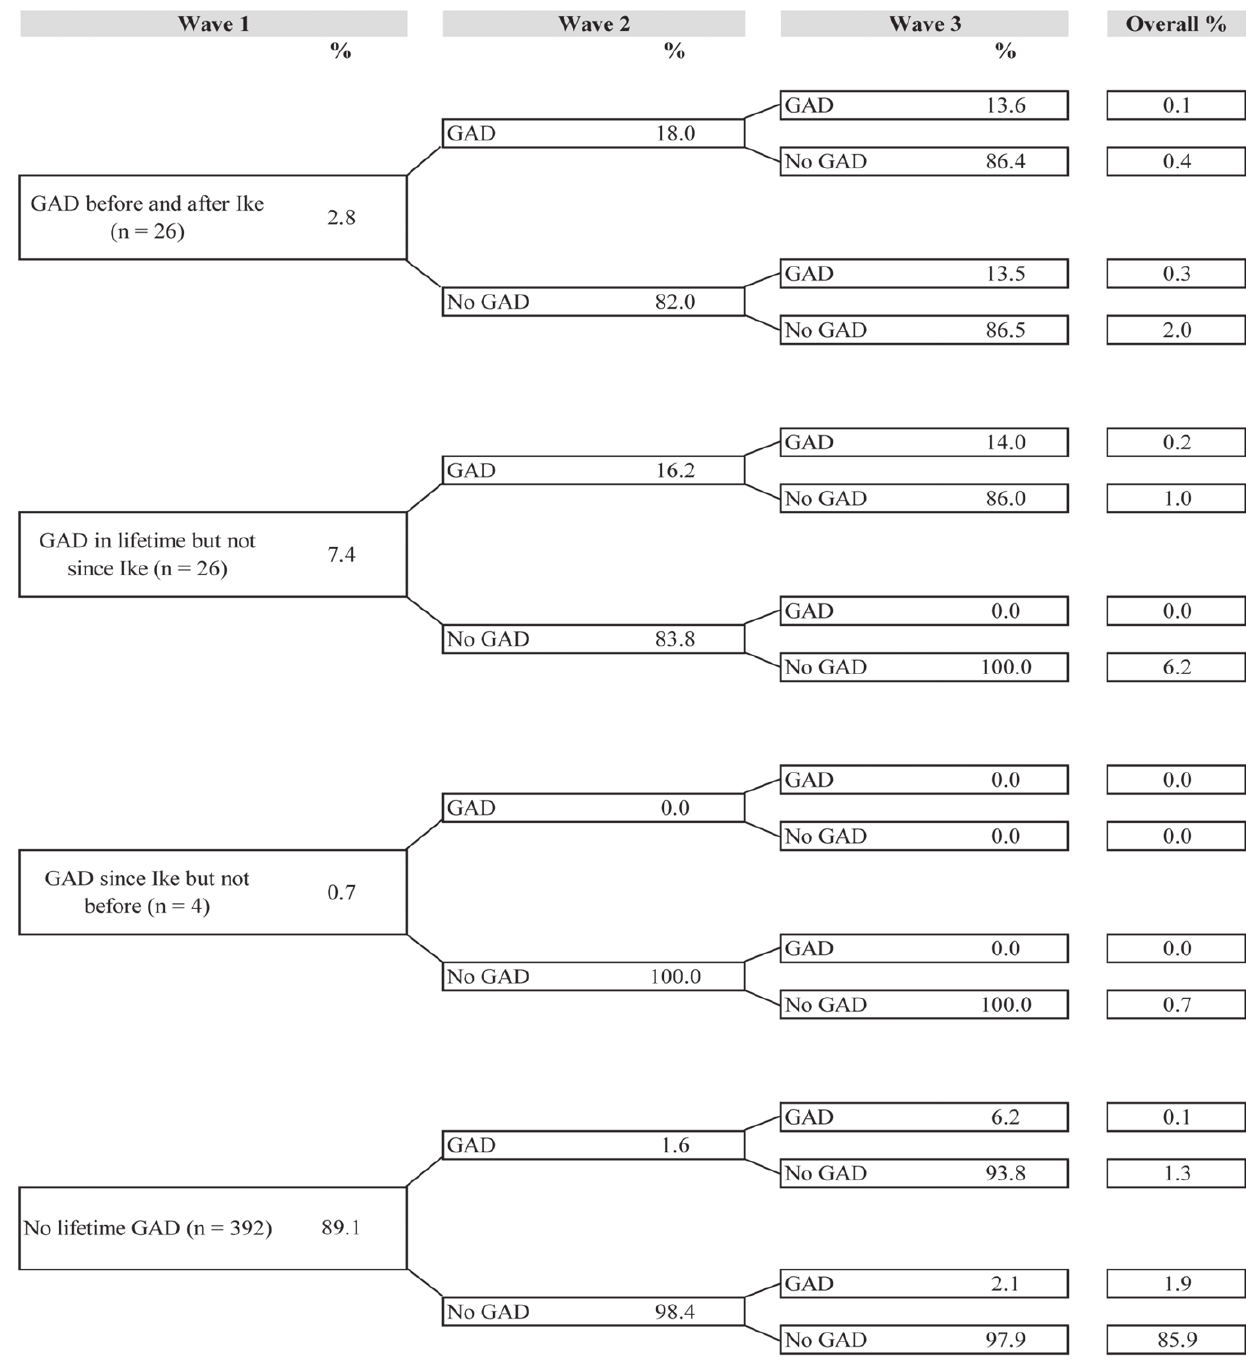
Figure 2. Trajectories of generalized anxiety disorder (n=448).